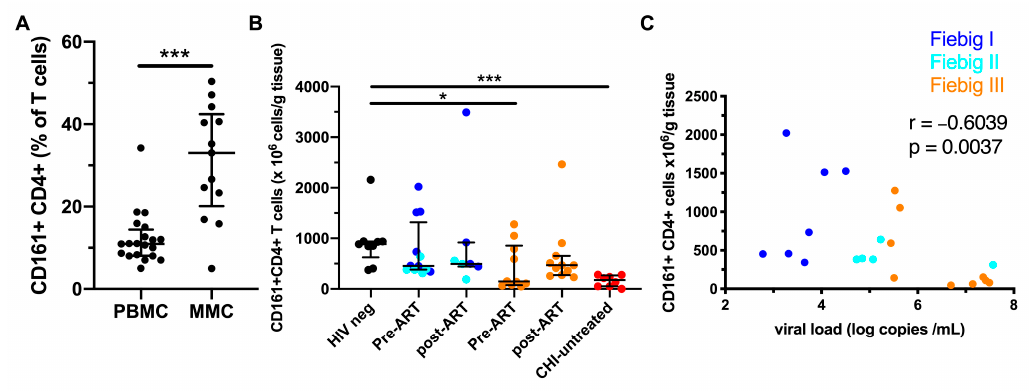
Figure 6. Depletion of CD161 + CD4 + T cells in the colonic mucosa is prevented by early ART. Frequency of CD161 + CD4 + T cells in peripheral blood ( n = 20) and colonic mucosa ( n = 13) of HIV-uninfected Thai subjects ( A ). Absolute number of colonic CD161 + CD4 + T cells in HIV-uninfected subjects (black, n = 9), Fiebig I (dark blue) Fiebig II (light blue), and Fiebig III (orange) HIV-infected individuals before ART ( n = 22) and after two years of ART initiated during AHI ( n = 18) ( B ). Association between VL and absolute number of colonic CD161 + CD4 + T cells during AHI ( C ). The lines and whiskers represent the median and interquartile range, respectively. *** p < 0.001 and * p <